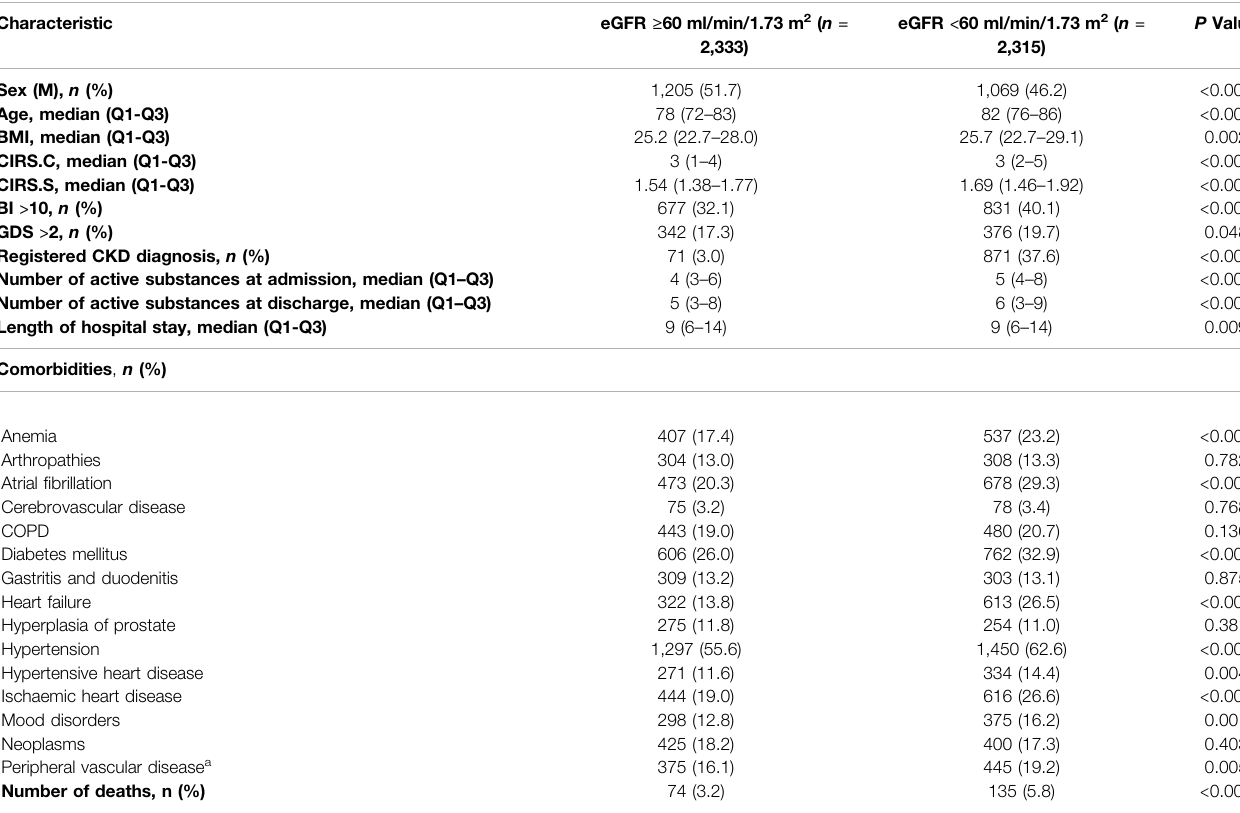
TABLE 1 | Socio-demographic characteristics of patients with an estimated glomerular fi ltration rate (eGFR) ≥ 60 ml/min/1.73 m 2 vs patients with an eGFR < 60 ml/min/ 1.73 m 2 .